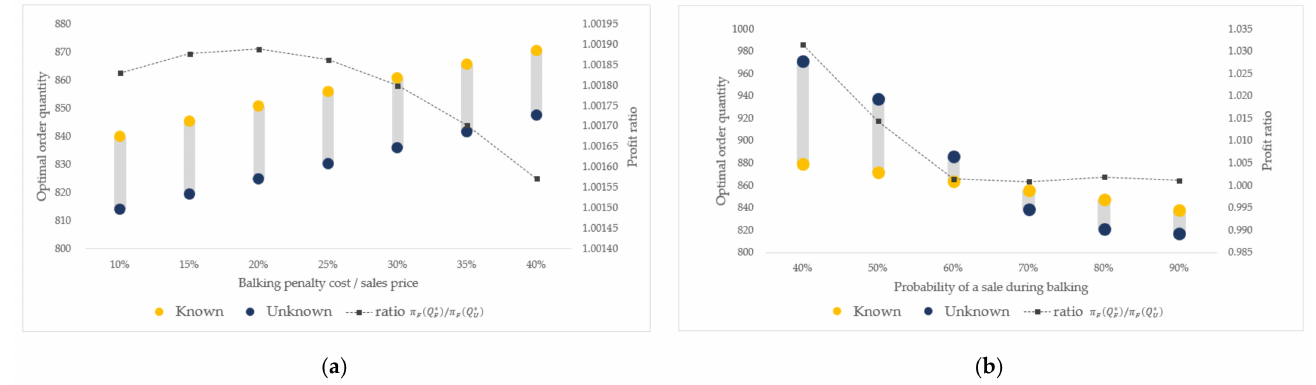
Figure 3. Optimal order quantity based on degree of change in two factors. ( a ) Effect of balking penalty cost and ( b ) effect of probability of a sale within customer balking